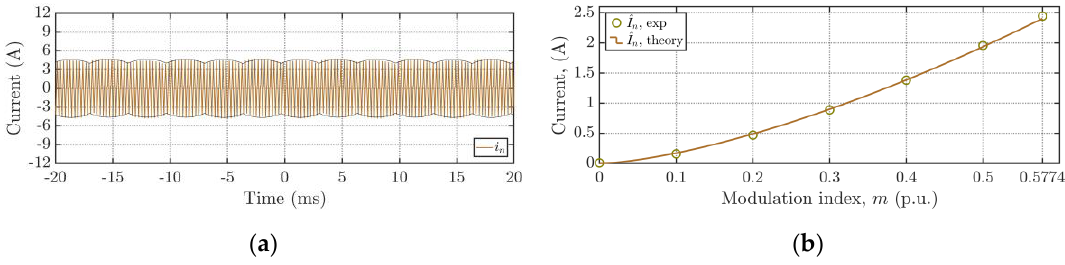
√ 3); ( b ) Neutral current ripple